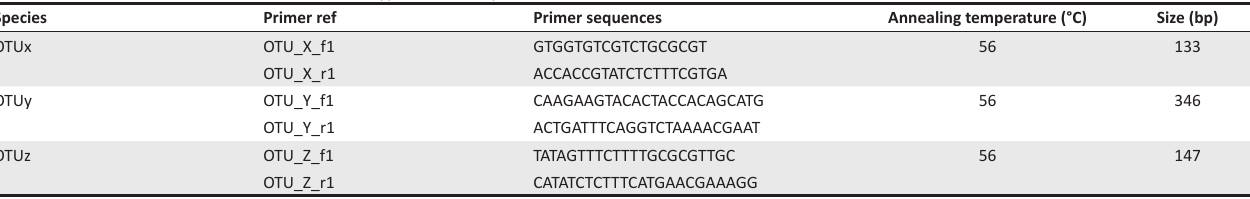
TABLE 2: Primers used for the detection of three cryptic Eimeria operational taxonomic units. Species